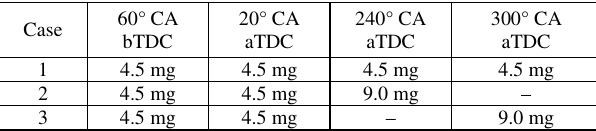
Fig. 1. Fuel injection strategy Table 3. Fuel injection strategy and fuel quantities